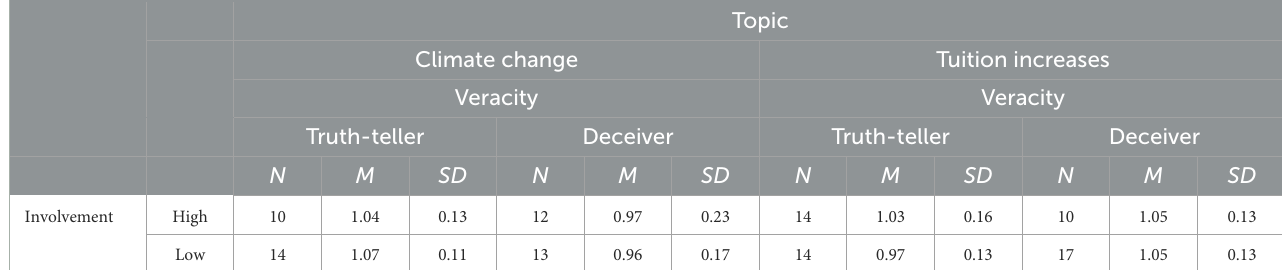
TABLE 4 Means and standard deviations for the change rate of